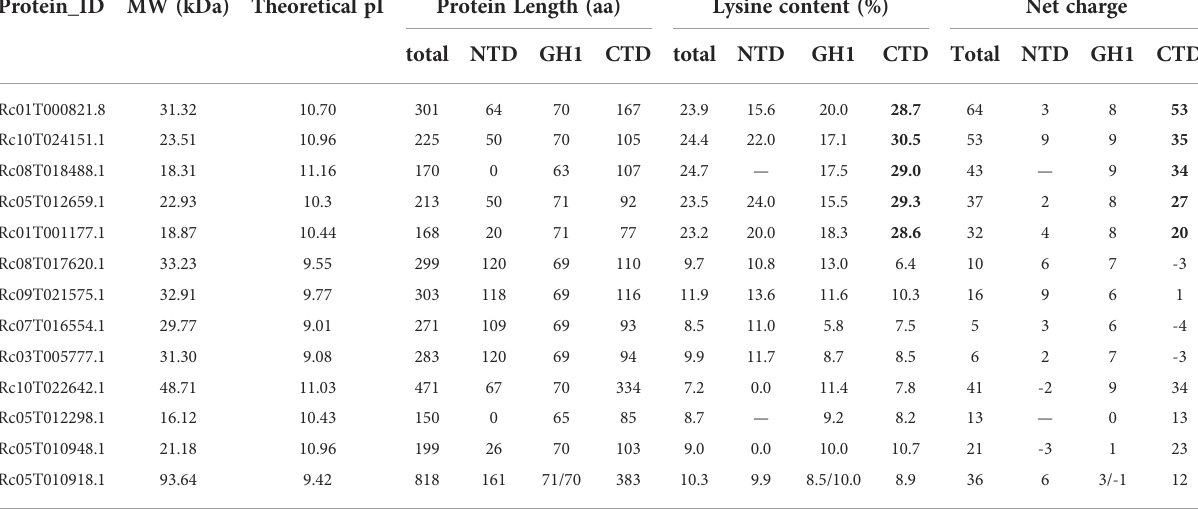
TABLE 1 Information of the GH1-containing proteins in castor